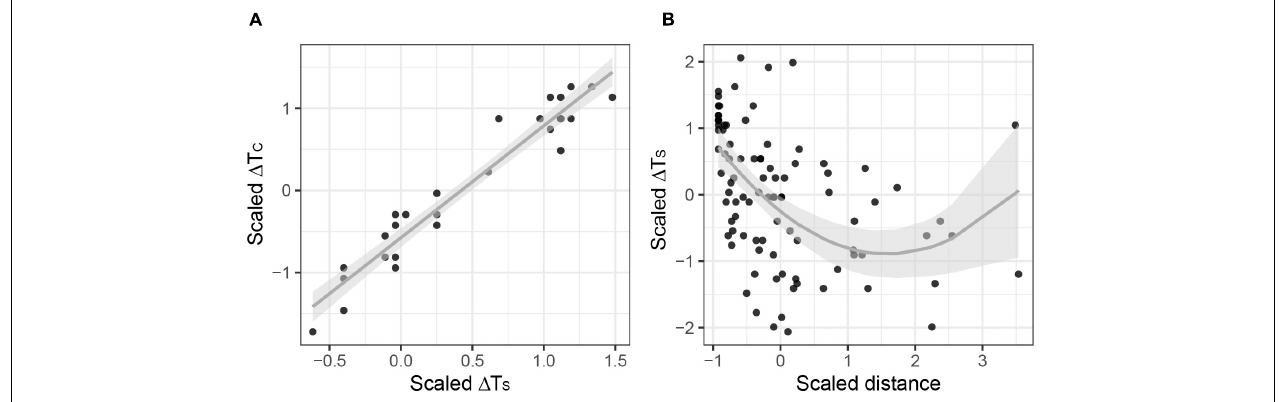
FIGURE 2 | (A) Linear relationship between (cid:49) T S and (cid:49) T C . (B) Binomial regressions between moved distance and (cid:49) T S .